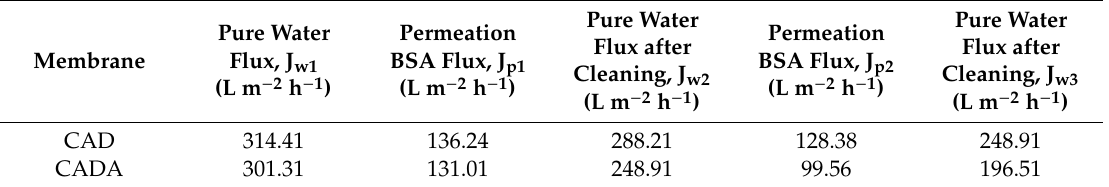
Table 5. Summary of the pure water flux, permeation bovine serum albumin (BSA) flux, and water flux after cleaning of as-prepared